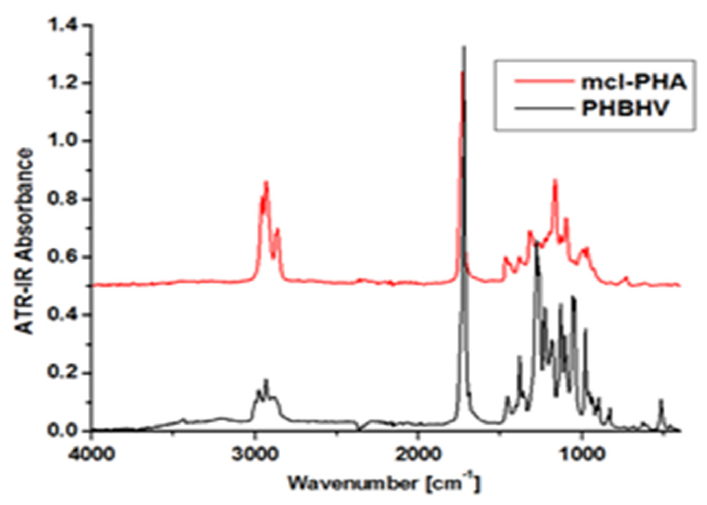
Figure 8. FTIR spectra of mcl-PHAs and PHBHV. Reprinted with permission from ref. [66], 2016, Lupescu et al., Rev.Chim.